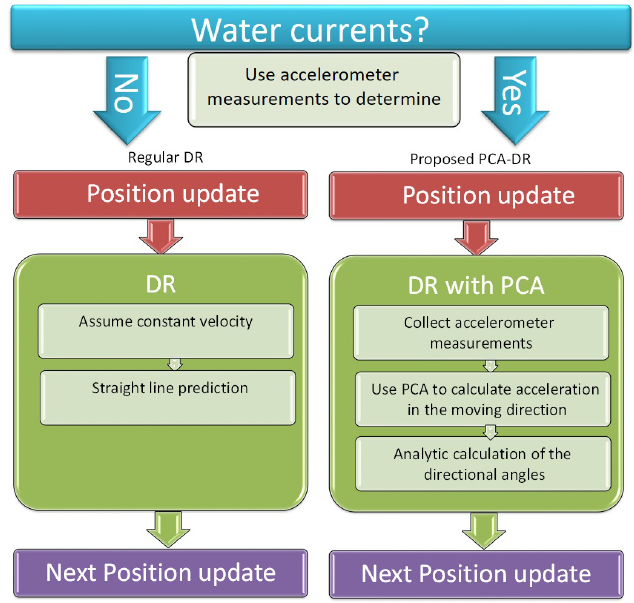
Figure 5. Flow chart illustrating the differences between PCA-DR and traditional